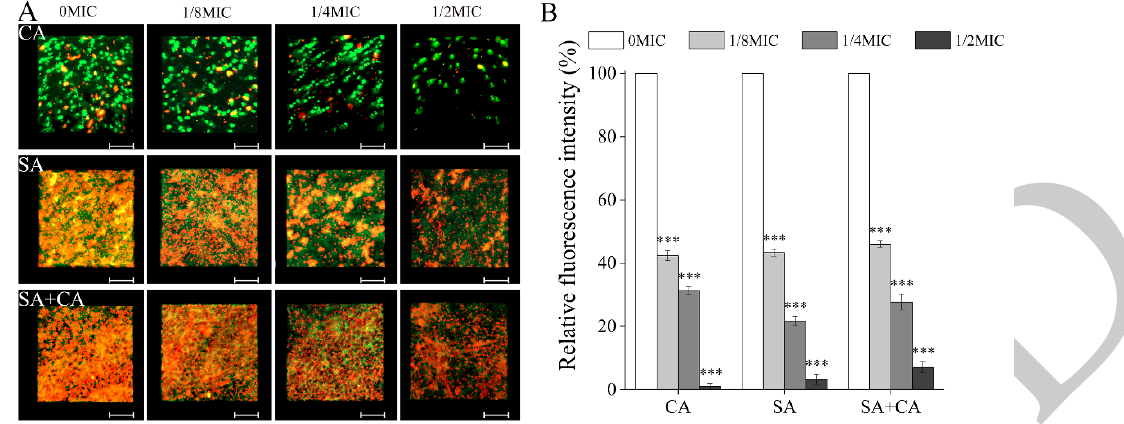
Figure 3. E ff ect of di ff erent concentrations of chelerythrine on the eDNA levels within C. albicans (CA) and S. aureus (SA) mono- and dual-species (SA + CA) biofilms by confocal laser scanning microscope. ( A ) eDNA was labelled with a red fluorescent membrane impermeable DNA-binding stain PI, and bacterial cells were stained with a green-fluorescent nucleic acid counterstain STYO 9. Scale bars represent 10 µ m. ( B ) The relative fluorescence intensity of eDNA in biofilms of each treatment group was plotted against that in untreated group by measuring red fluorescence intensities using KS 400 version 3.0 software. Bars represent the standard deviation ( n = 3). *** p < 0.001.